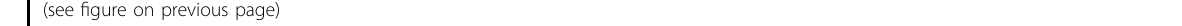
Fig. 6 Raloxifene alleviates the progression of scoliosis. a Scheme of Raloxifene treatment in AIS animal model. Scoliosis mouse model was generated as aforementioned. After the occurrence of scoliosis, intramuscular Raloxifene injections were performed at the concave para-spinal muscle once every 3.5 days for 2 weeks (from the 5th week to the 7th week). The spinal alignment and para-spinal muscle size were then analyzed at 9th week. b Representative immuno fl uorescent staining of Raloxifene-treated or DMSO-treated concave para-spinal muscle 2 weeks after fi nal injection. Cryosections were obtained from para-spinal muscle at the concave side with either DMSO mock treatment or Raloxifene treatment and subjected for laminin immuno fl uorescent staining. Green indicated laminin; blue indicated DAPI staining of nuclei. The merged images were shown. Scale bars: 100 μ m. c Statistical analysis of the CSA of myo fi bers in Raloxifene treated or DMSO treated concave para-spinal muscle. At least 500 fi bers were analyzed for each sample. Error bars indicated standard deviation ( n = 5). ** P < 0.01. d In vivo X-ray images of spinal alignment before and after Raloxifene treatment. e Statistical analysis of Cobb angle in coronal plane after DMSO mock treatment ( n = 8) and Raloxifene treatment ( n = 8), respectively. 5th week indicated before treatment; 9th week indicated after treatment. Error bars indicated standard deviation ( n = 8). ns indicated no signi fi cant changes; *** P < 0.001. f Statistical analysis of kyphosis in sagittal plane after DMSO mock treatment ( n = 8) and Raloxifene treatment ( n = 8), respectively. 5th week indicated before treatment; 9th week indicated after treatment. Error bars indicated standard deviation ( n = 8). ns indicated no signi fi cant changes; *** P < 0.001. g Asymmetric ESR1 signaling increased the susceptibility to AIS. Restoration of ESR1 signaling by Raloxifene (indicated by R in yellow triangles) alleviated the progression of